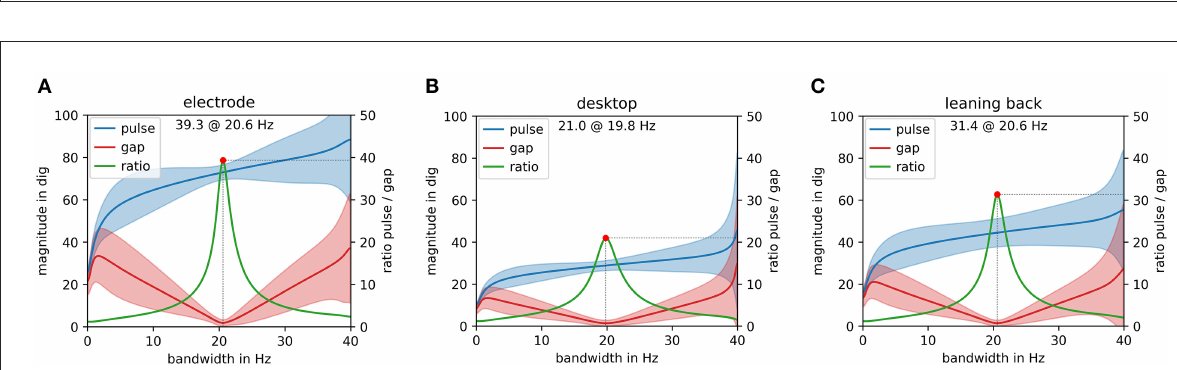
FIGURE10 Determination of the optimal filter bandwidth B , centered at f 0 , for the scenario’s three ways of coupling. From 0 . 1to39 . 9Hz in steps of 0 . 1Hz, 399 iterations each, considering the mean p and standard deviation of the pulse amplitudes p (blue), the mean | g | and standard deviation of the absolute gap magnitudes | g | (red), the remaining ripple, respectively, and the ratio of the means p / | g | (green) with the maximum marked (red dot). Best ratio 39 . 3dig for 20 . 6Hz by directly touching the electrode (A) , second best 31 . 4dig for 20 . 6Hz by leaning back (C) , and lowest 21 . 0dig for 19 . 8Hz by touching the desktop (B) . The filter bandwidth B of 20Hz is, therefore, selected as optimal. Based on signals from the left wrist